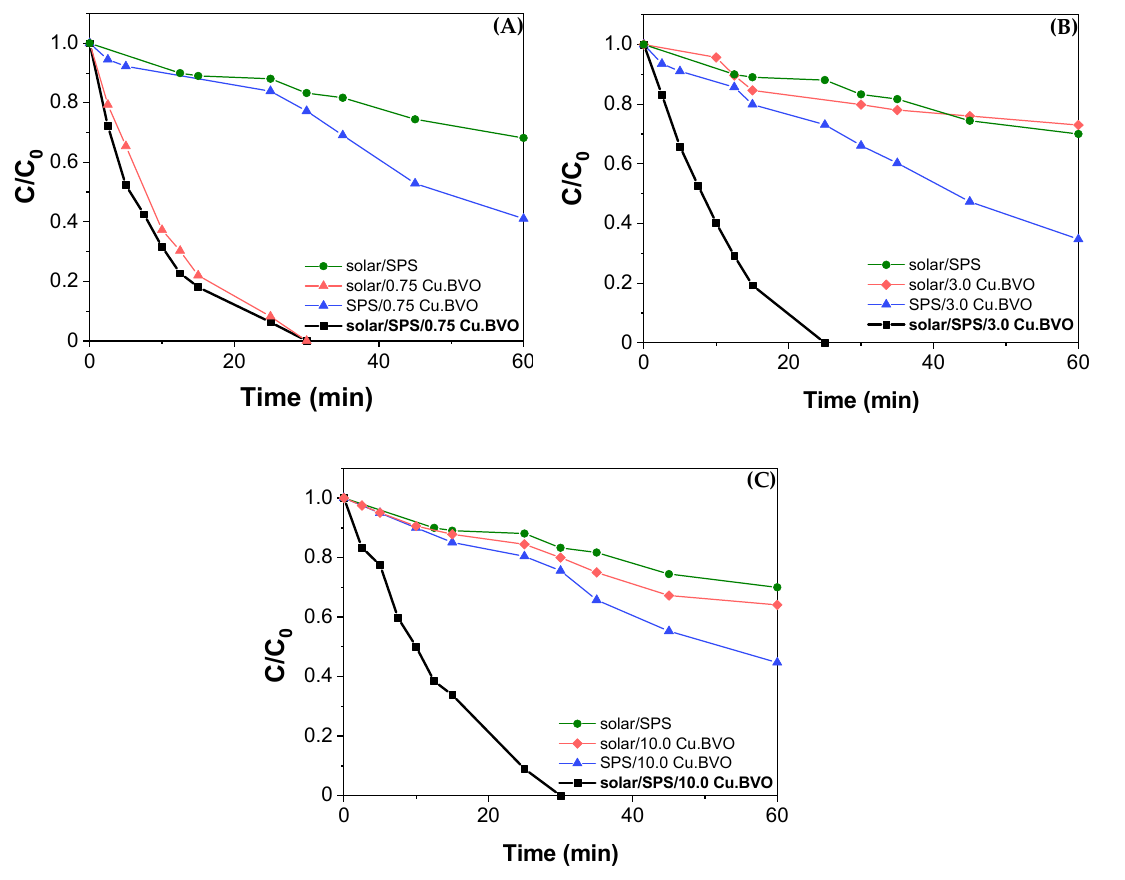
Figure 5. Removal of SMX using solar/SPS, solar/catalyst, SPS/catalyst, and solar/SPS/catalyst for ( A ) 0.75 Cu.BVO, ( B ) 3.0 Cu.BVO, and ( C ) 10.0 Cu.BVO in UPW. Experimental conditions: 0.5 mg/L SMX, 100 mg/L SPS, and 500 mg/L catalyst.